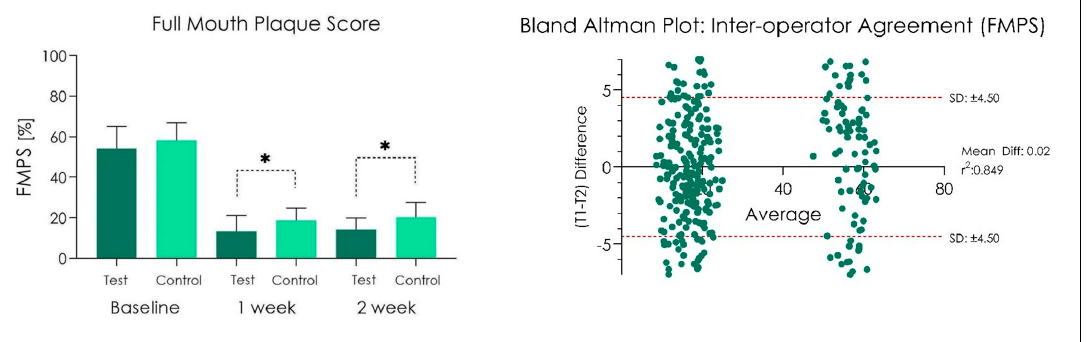
Figure 2. FMPS measurements at baseline, after 1 and 2 weeks. * p < 0.05. One-way ANOVA fol-